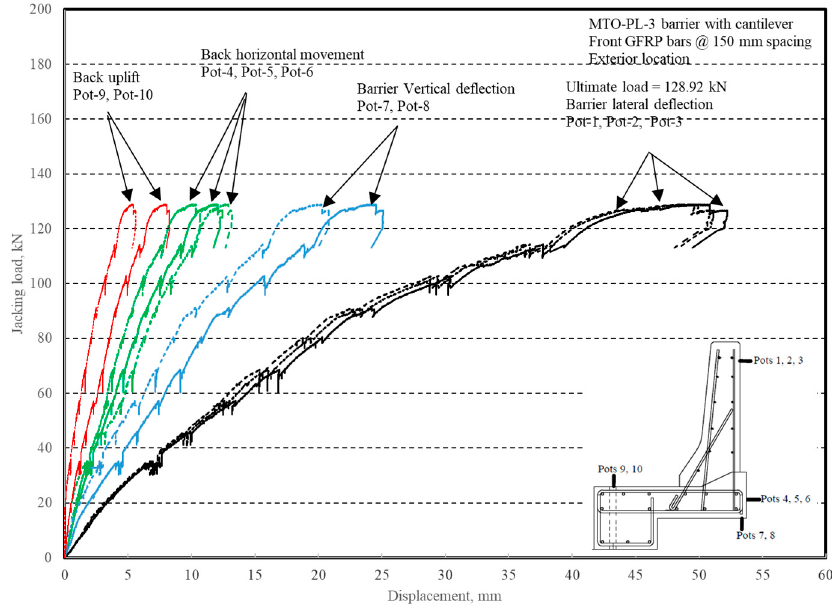
Figure 19. Specimen # 3: Load vs. displacement history.